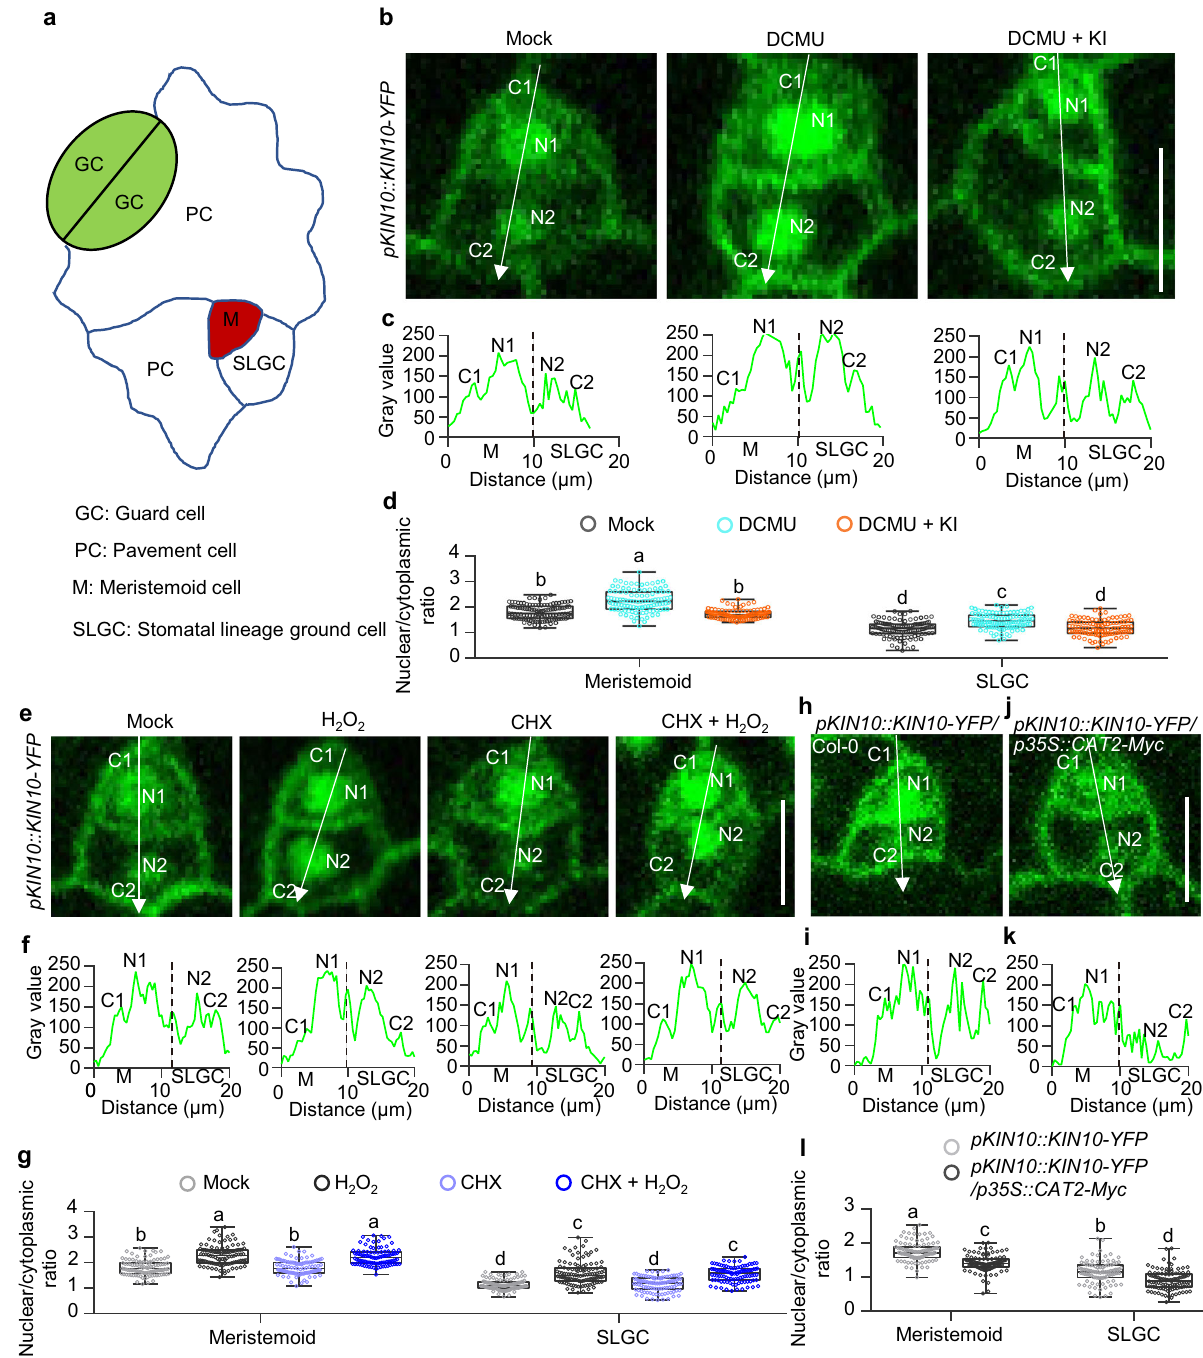
Fig.1|H 2 O 2 inducesthenuclearlocalizationofKIN10.a Diagramofprogressive stomatal lineage in the Arabidopsis early leaf epidermis. M meristemoid cell, SLGC stomatal lineage ground cell, PC pavement cell, GC guard cell. b – d KI prevents DCMU-induced nuclear localization of KIN10-YFP in M and SLGC. Seedlings of pKIN10::KIN10-YFP transgenic plants were treated with or without 50 μ M DCMU and/or 1mM KI for 12h. n =113 (Mock), n =107 (DCMU) and n =108 (DCMU+KI)meristemoidorSLGCcellsin10cotyledonswereanalyzedbyImageJ in d . e – g H 2 O 2 induces the nuclear localization of KIN10-YFP in plants. Seedlings of pKIN10::KIN10-YFP transgenic plants were treated with or without 2mM H 2 O 2 and/or 50 μ M CHX for 2h. n =102 (Mock), n =110 (H 2 O 2 ), n =103 (CHX) and n =101 (CHX+H 2 O 2 ) meristemoid or SLGC cells in 10 cotyledons were analyzed by ImageJ in g . h – l Overexpression of CAT2 reduces the nuclear localization of KIN10-YFP. n =102(Col-0), n =104( p35S::CAT2-Myc )meristemoidorSLGCcellsin 10cotyledonswereanalyzedbyImageJin l .Seedlingsof pKIN10::KIN10-YFP ( b – g )